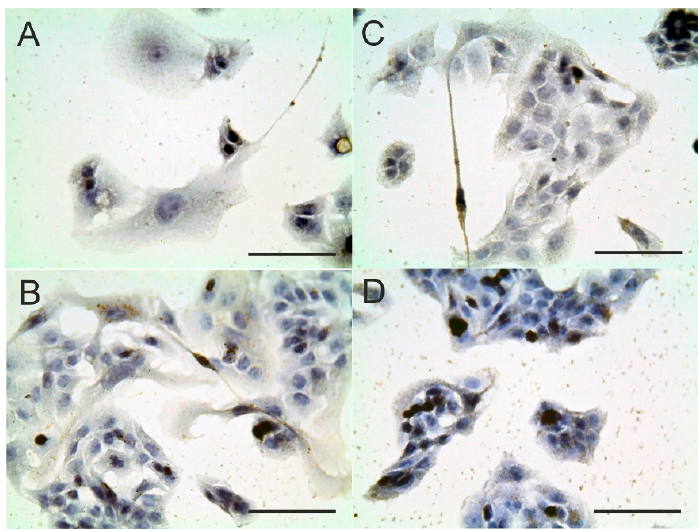
Figure 3. Vimentin and p53 expression in HepG2 cells after 48 h cultivation in medium contained 10 μ g/mL C 60 FAS: ( A ): vimentin expression, control; ( B ): vimentin expression, C 60 FAS; ( C ): p53 expression, control; ( D ): p53 expression, C 60 FAS; hematoxylin, ×400, scale 100 μ m.